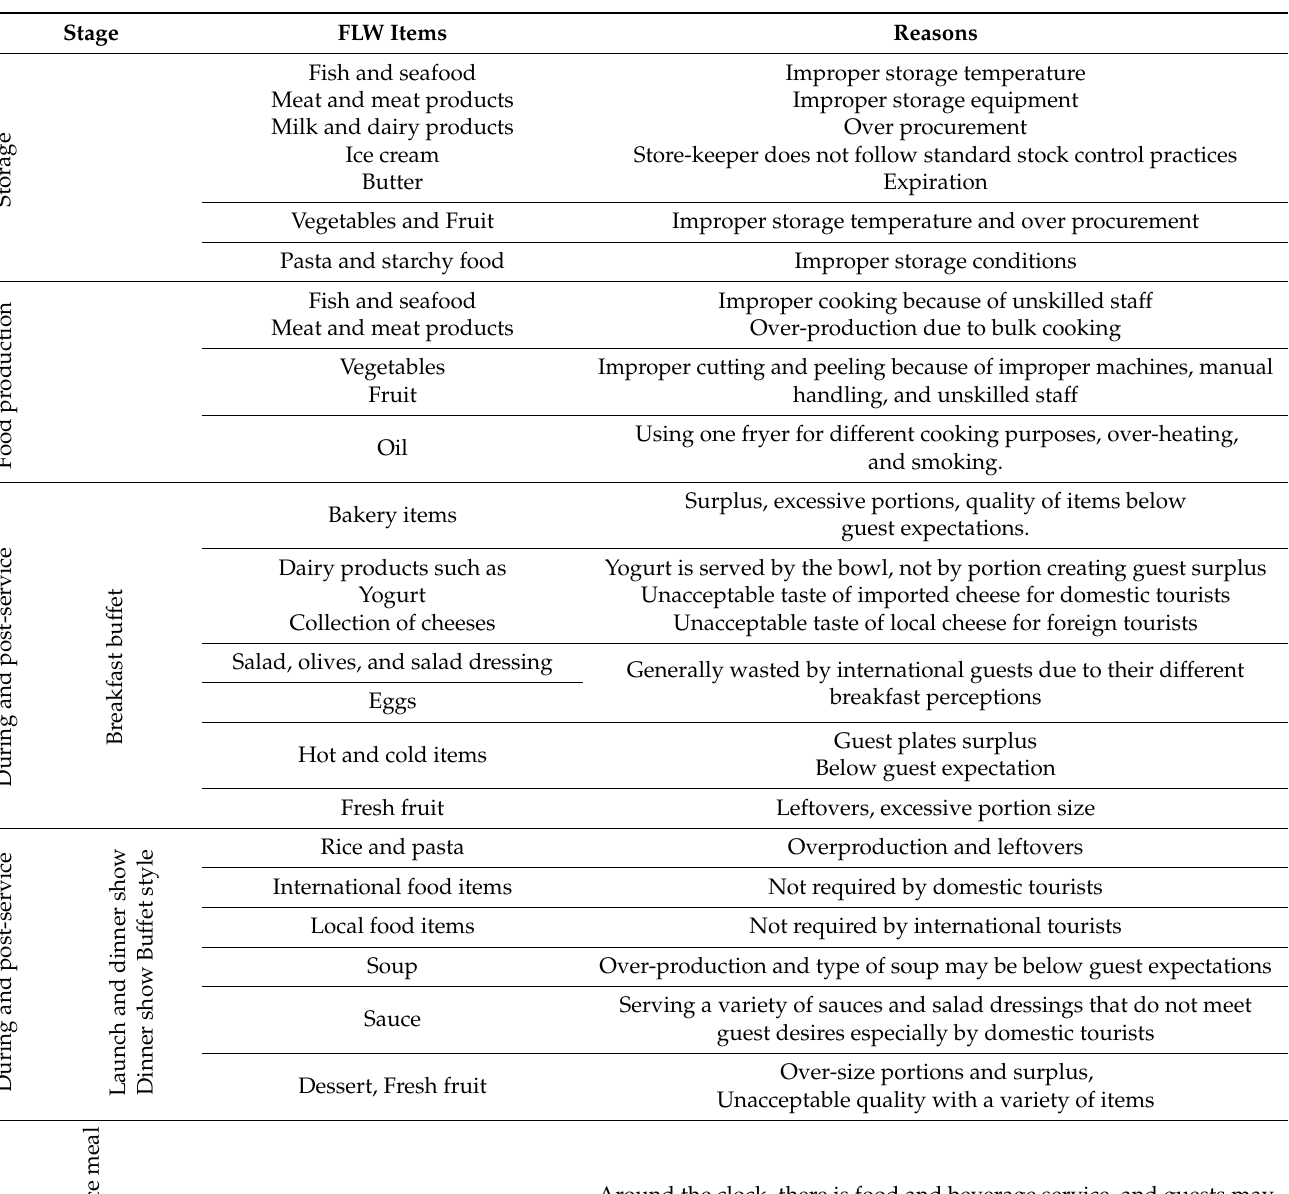
Table 3. Commonly wasted food in all-inclusive